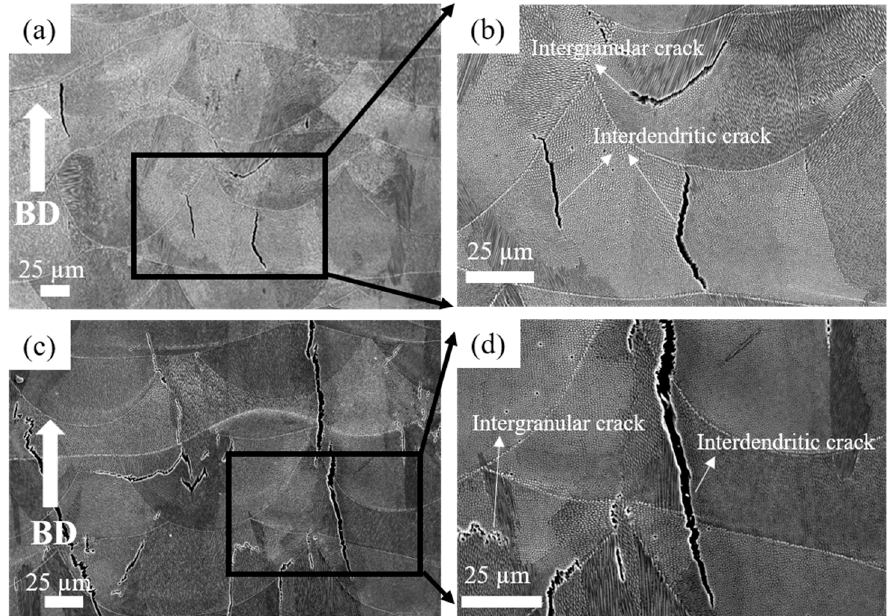
Figure 2. SEM micrographs of as-built HX specimen at ( a ) low magnification and ( b ) high magnifica- tion, and HX-a as-built specimen at ( c ) low magnification and ( d ) high